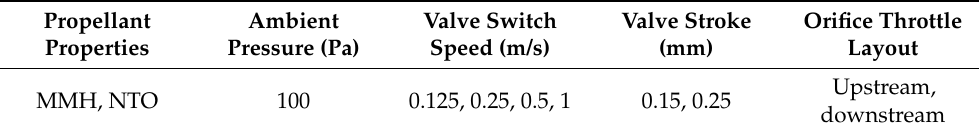
Table 1. Conditions of simulation cases.